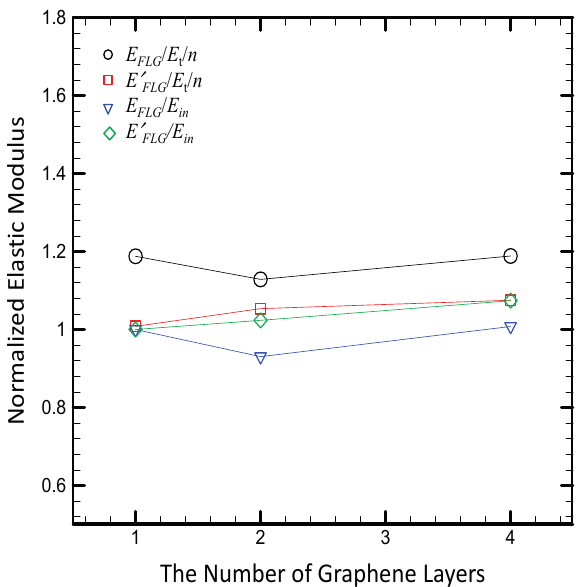
Figure 17. The normalized elastic moduli of FLG determined under small deformation. E and E ′ are the elastic moduli of FLG determined from free-standing indentation FLG FLG using the δ / L - ε relationship and the δ / L - ε relationship, t